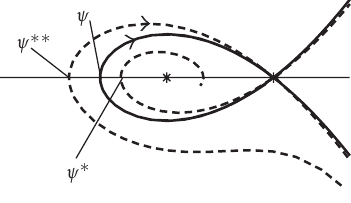
Figure 3.7. Separatrices related to the saddle point (1,0) for a = 0 (solid lines) and a < 0 (dashed